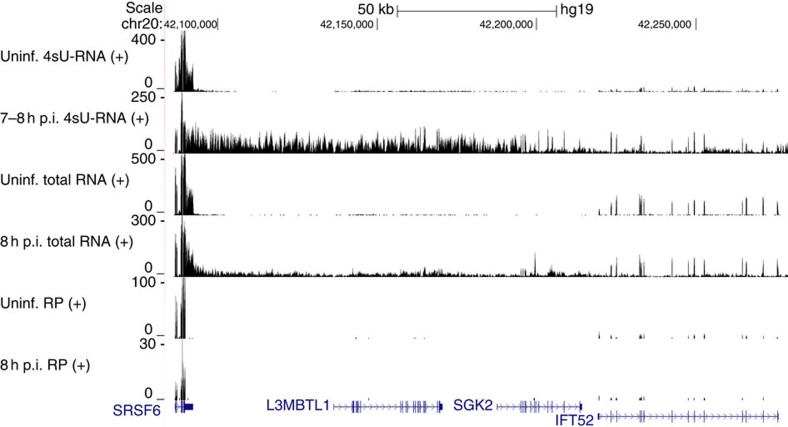
Disruption of transcription termination of the SRSF6 gene.Lytic HSV-1 infection induced massive transcriptional activity downstream of the SRSF6 gene at 7–8 h p.i. extending into neighbouring genes. Downstream genes were induced sixfold (L3MBTL1), 68-fold (SGK2) and 2.5-fold (IFT52) at 7–8 h p.i., respectively (Supplementary Data 1). Read counts per genome position are shown for 4sU-RNA (row 1 and 2), total RNA (row 3 and 4) and ribosome profiling (RP, row 5 and 6). Ribosome profiling reads to a U6 snRNA repeat at chr20:42,101,653-42,101,758 were masked. For each gene, direction (arrowheads), exons (vertical bars, narrow bars=untranslated sequences) and introns (horizontal lines between bars) are indicated in blue at the bottom.